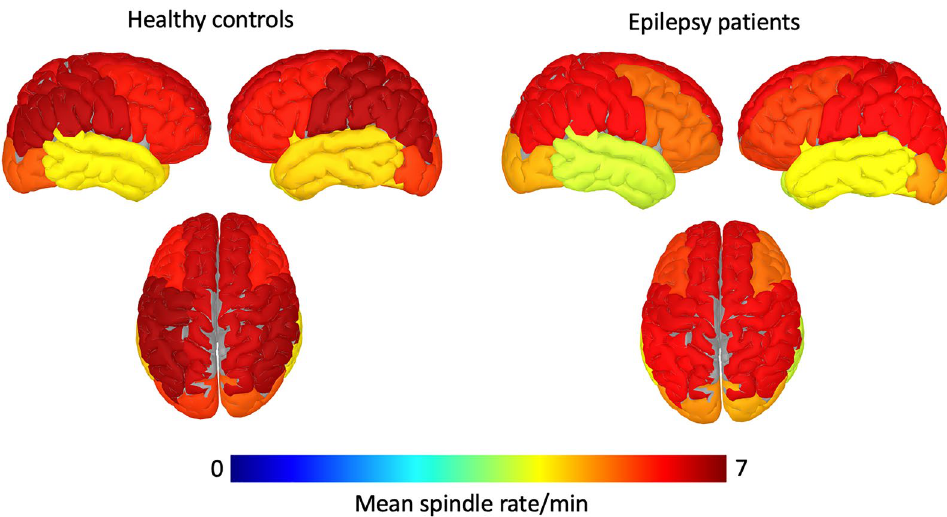
Figure 2. Mean spindle rates per region (frontal, central, temporal, parietal, occipital and midline) in healthy controls and patients with epilepsy for all N2